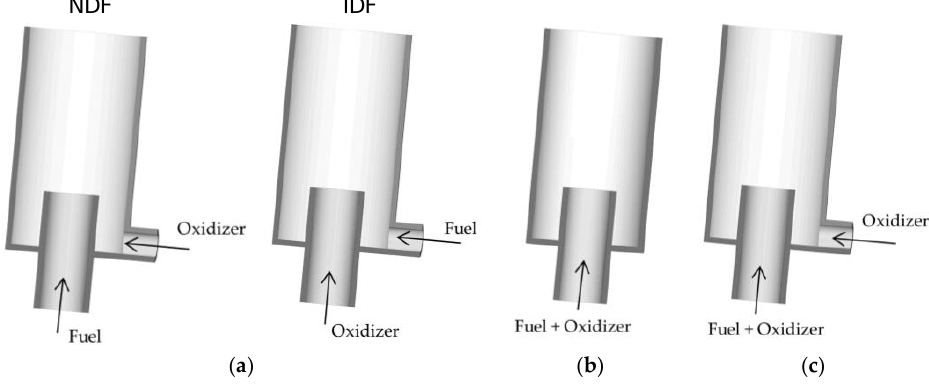
Figure 1. The types of burner ( a ) non-premixed; ( b ) premixed; ( c ) partial premixed.